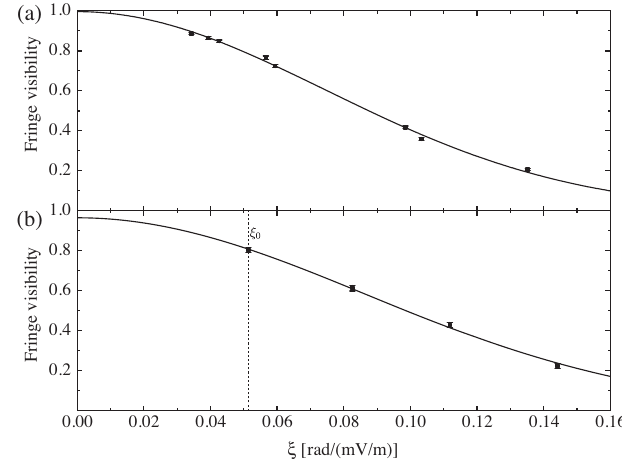
FIG. 15. Visibility as a function of the field sensitivity. Visibility of the fringes measuring the coherence of (a) j 50 c iþ j 52 m 2 i and (b) j 52 c i þ j 52 m 1 i , as function of the phase sensitivity of the fringes to the electric field ξ . The points are experimental (with statistical error bars), the line is a Gaussian fit of the form V ¼ V 0 exp ð − ξ 2 σ 2 F = 2 Þ , where V 0 is the intrinsic visibility that the fringes would have in the absence of electric field